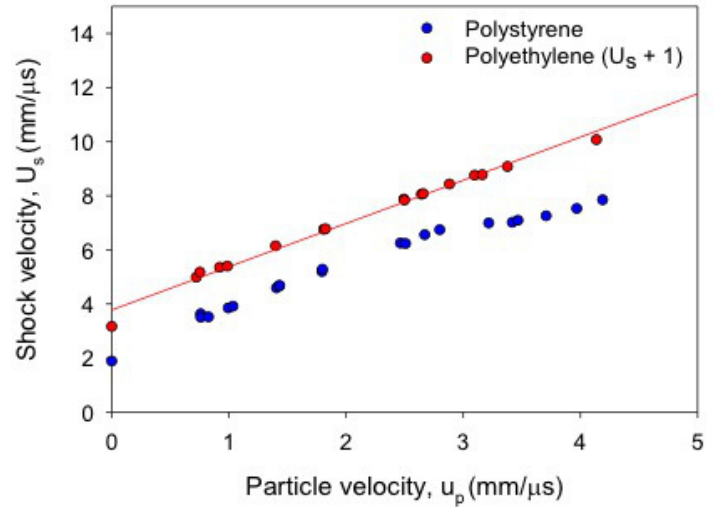
Figure 10. Shock Hugoniot data in the U − u plane for polyethylene (red, offset by Us + 1) and polystyrene (blue). The structure around u = 3 km/s is greater in polystyrene, which undergoes a larger volume